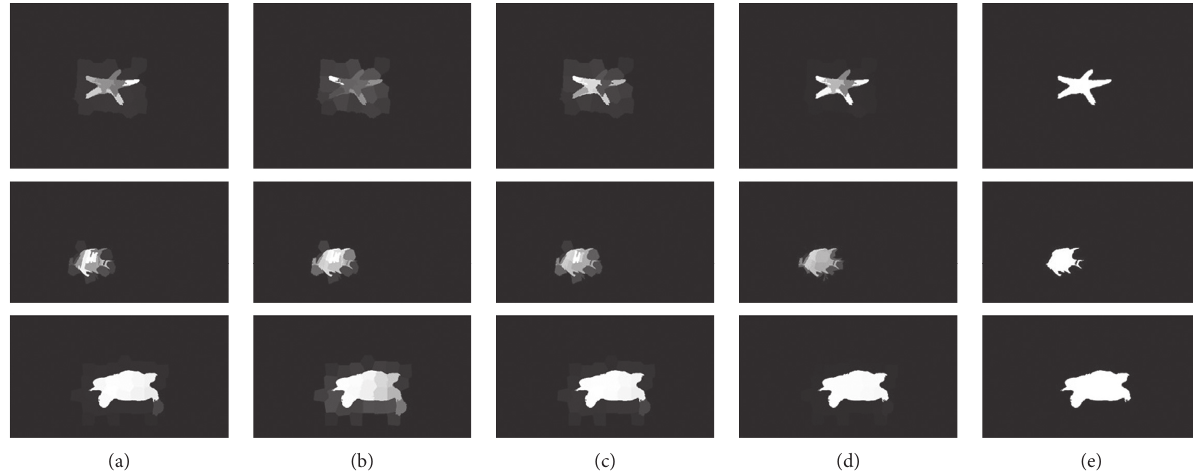
Figure 4: Seed propagation for the samples in Figure 3. (a-b) Detection results propagated in Lab and LBP spaces. (c) Initial detection result. (d) Refined result. (e) Binary